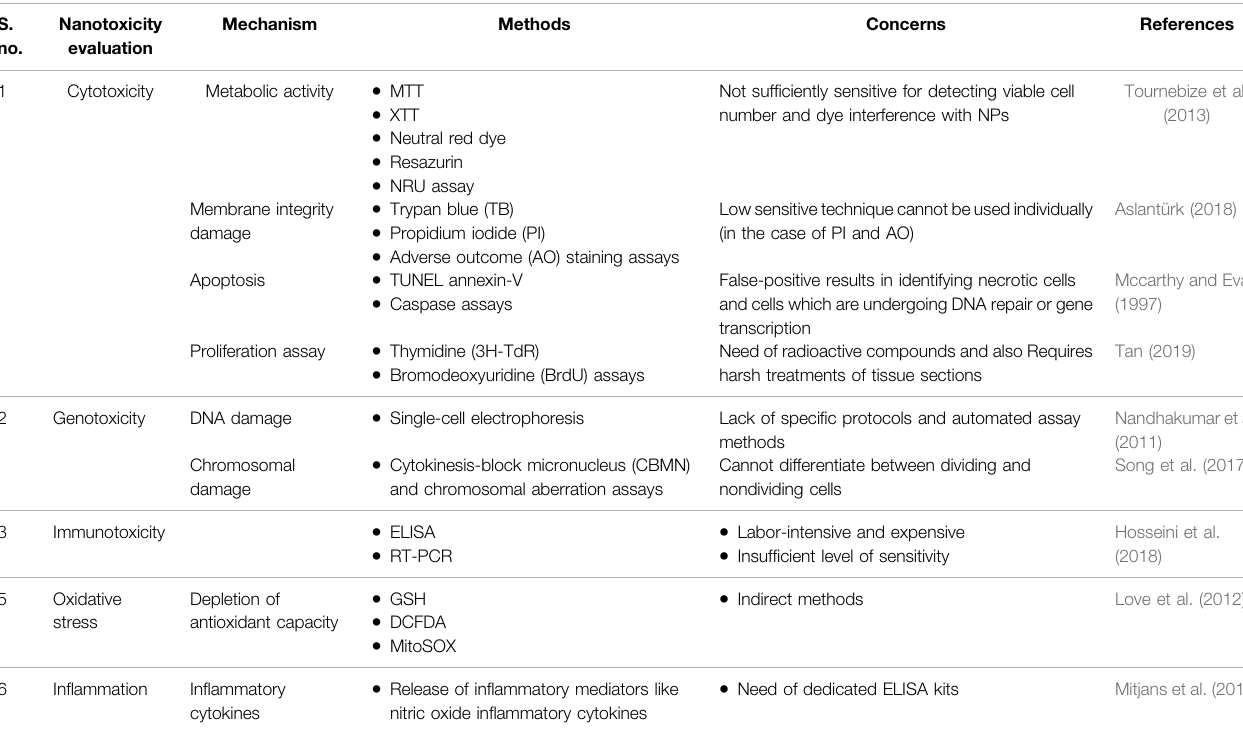
TABLE 2 | Table enlists the common disadvantages associated with the routine cytotoxicity evaluation methods S.